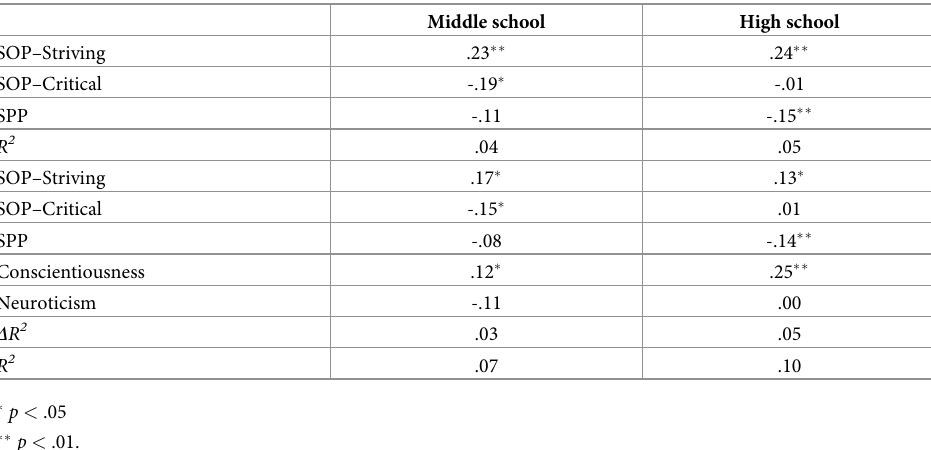
Table 5. Standardized regression weights and proportion of variance accounted in scholastic